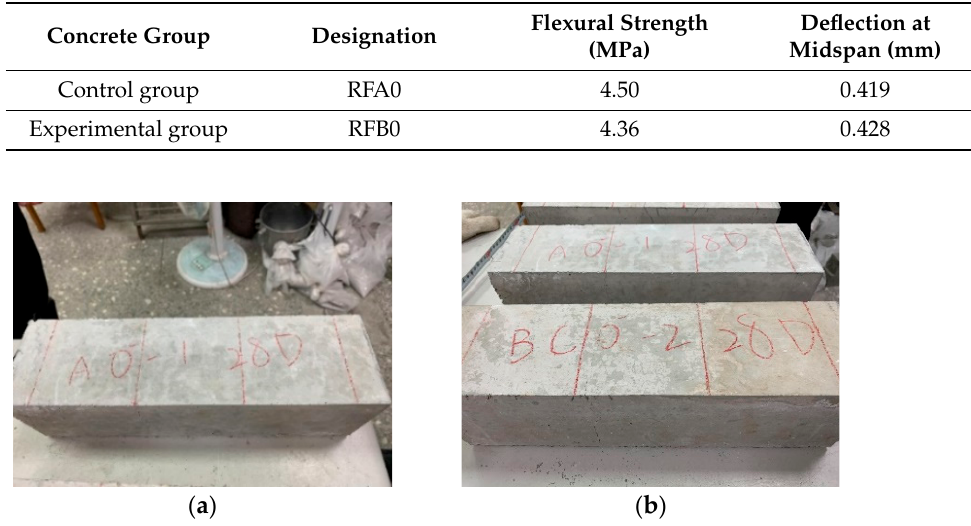
Figure 21. Destruction appearance of the concrete specimens after flexural test at room temperature: ( a ) control group; ( b ) experimental group. Table 17. Results of flexural test of the concrete at room temperature.